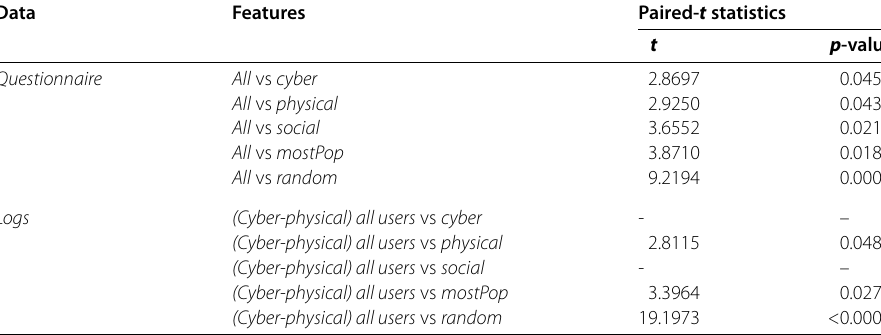
Table 9 Paired t -test results